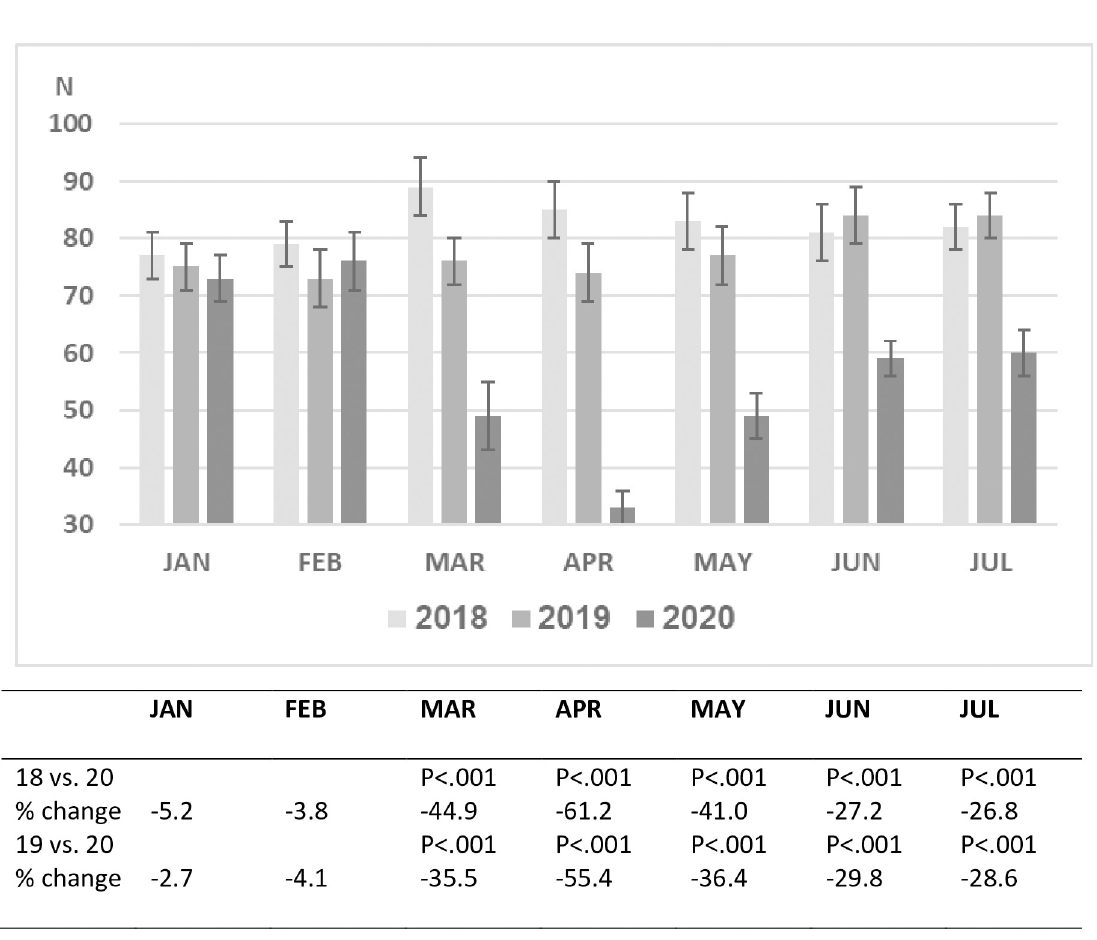
Fig 1. Mean daily PED visits by month and